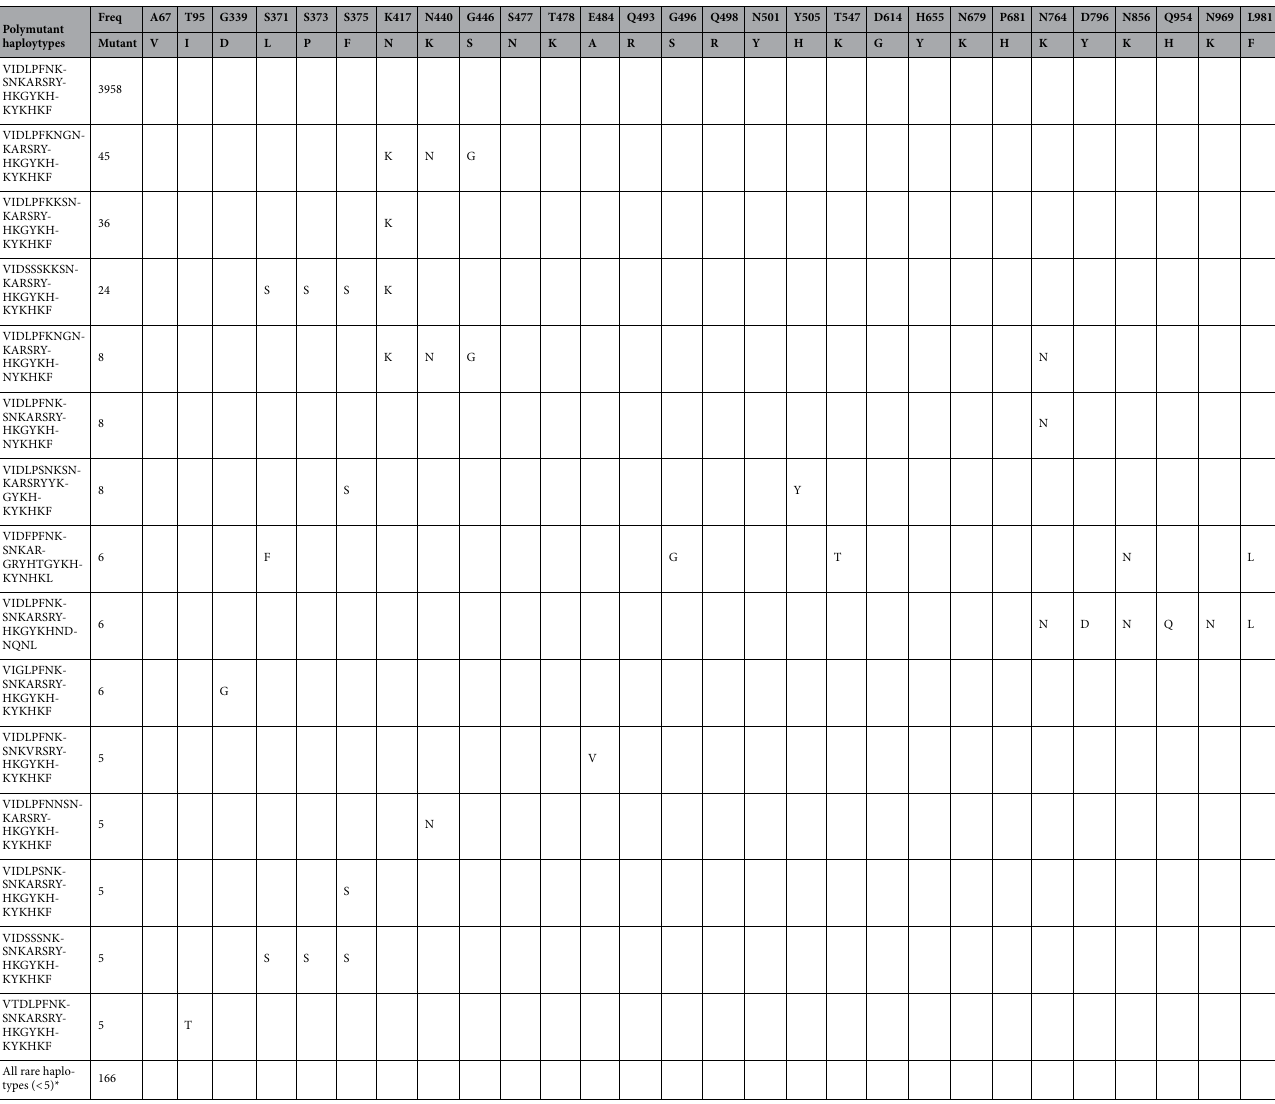
Table 1. Haplotype frequencies of 28 polymutants (A67V, T95I, G339D, S371L, S373P, S375F, K417N, N440K, G446S, S477N, T478K, E484A, Q493R, G496S, Q498R, N501Y, Y505H, T547K, D614G, H655Y,